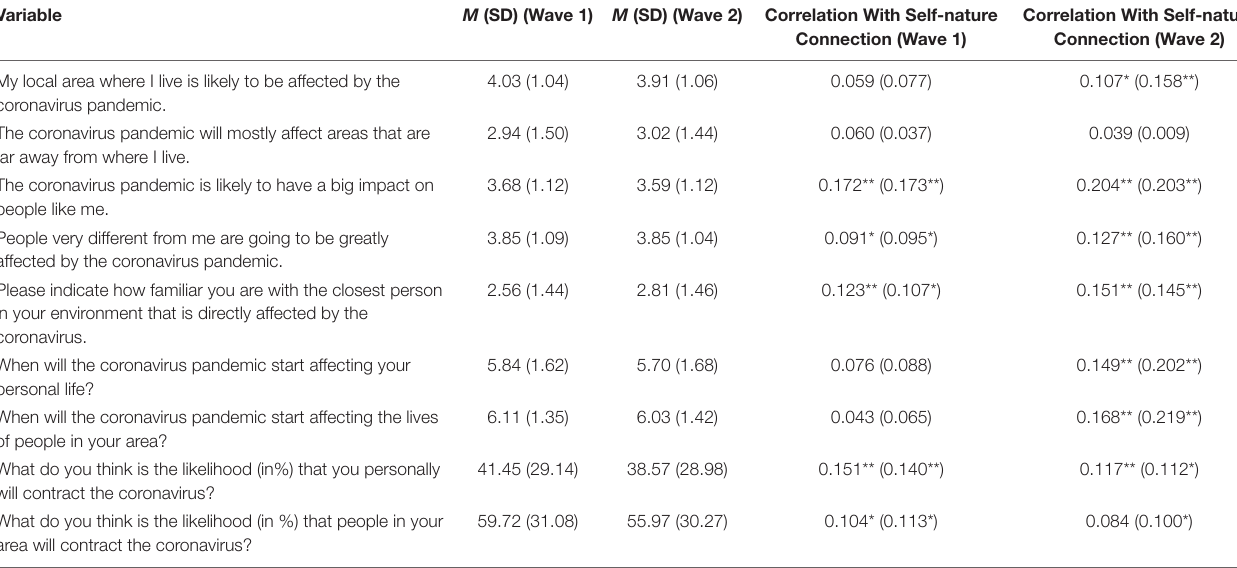
TABLE 9 | Psychological distance and self-nature connection: Descriptive statistics and correlations. Variable M (SD) (Wave 1) M (SD) (Wave 2) Correlation With Self-nature